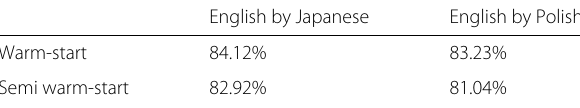
Table 1 Model architecture for each setup